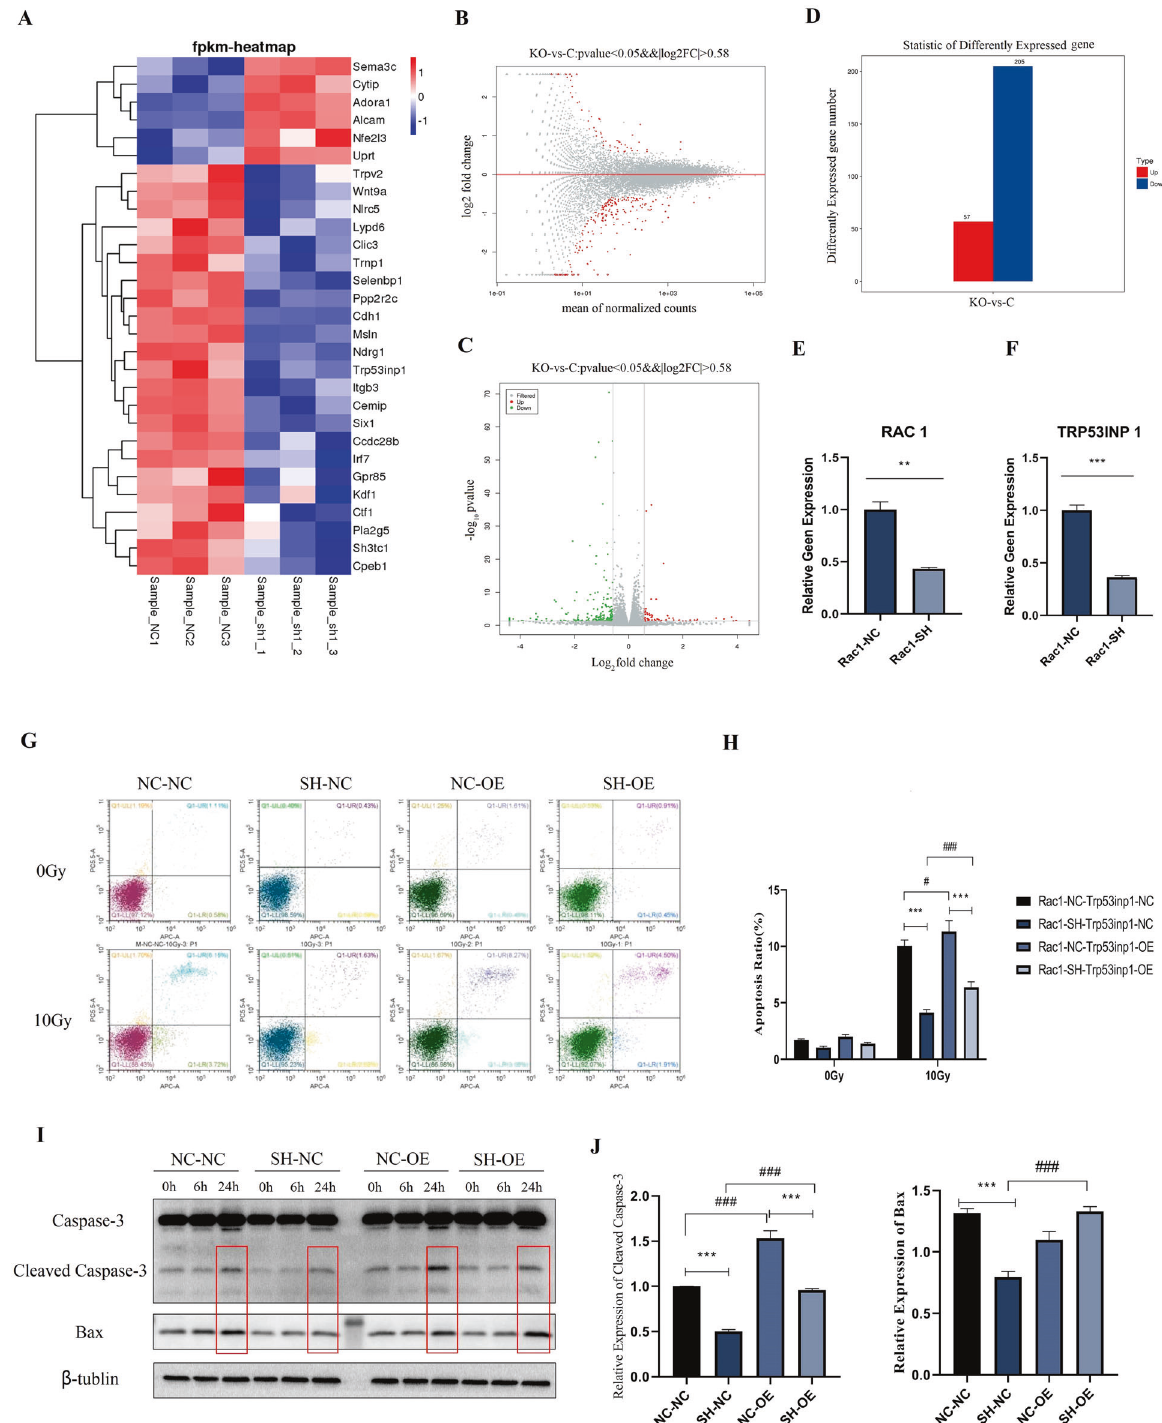
Fig. 3 Identi fi cation of Trp53inp1 as the critical downstream target of Rac1 by RNA-Seq analysis. RNA-seq and qPCR analysis of differential expression genes between Rac1 knockdown (Rac1-SH) and control (Rac1-NC) MLE-12. A Cluster analysis results of differential expression genes. B – D MA diagram, Volcano map, and histogram of differential expression genes. Red column represents the genes upregulated by Rac1 knockdown, and blue represents the genes downregulated. P <0.05, |log 2FC|> 0.58. A total of 262 differential genes were caused by Rac1 knockdown, of which 205 genes were downregulated and 57 genes were upregulated. E , F qPCR analysis of relative gene expression level of Rac1 and Trp53inp1 between Rac1-SH and Rac1-NC MLE-12. Trp53inp1 overexpression (OE) and negative control (NC) MLE-12 cell lines were constructed on the basis of Rac1-NC and Rac1-SH MLE-12 cells, yielding a total of 4 kinds of genetically modi fi ed MLE-12 cells, which were Rac1-NC + Trp53inp1-NC (represented as NC-NC), Rac1-SH + Trp53inp1-NC (represented as SH-NC), Rac1-NC + Trp53inp1-OE (represented as NC-OE) and Rac1-SH-Trp53inp1- OE (represented as SH-OE). All 4 kinds of cells were collected before (0 Gy) and at designed time points after 10 Gy of irradiation. G , H Apoptosis ratio detected by a fl ow cytometer. I , J Apoptosis-related proteins, Bax and Caspase-3 were detected by WB analysis. ** and *** represented P < 0.01 and 0.001 between the corresponding groups, respectively. The error value was expressed as mean ±SEM. Experiments were repeated three times. Cell Death Discovery (2022)